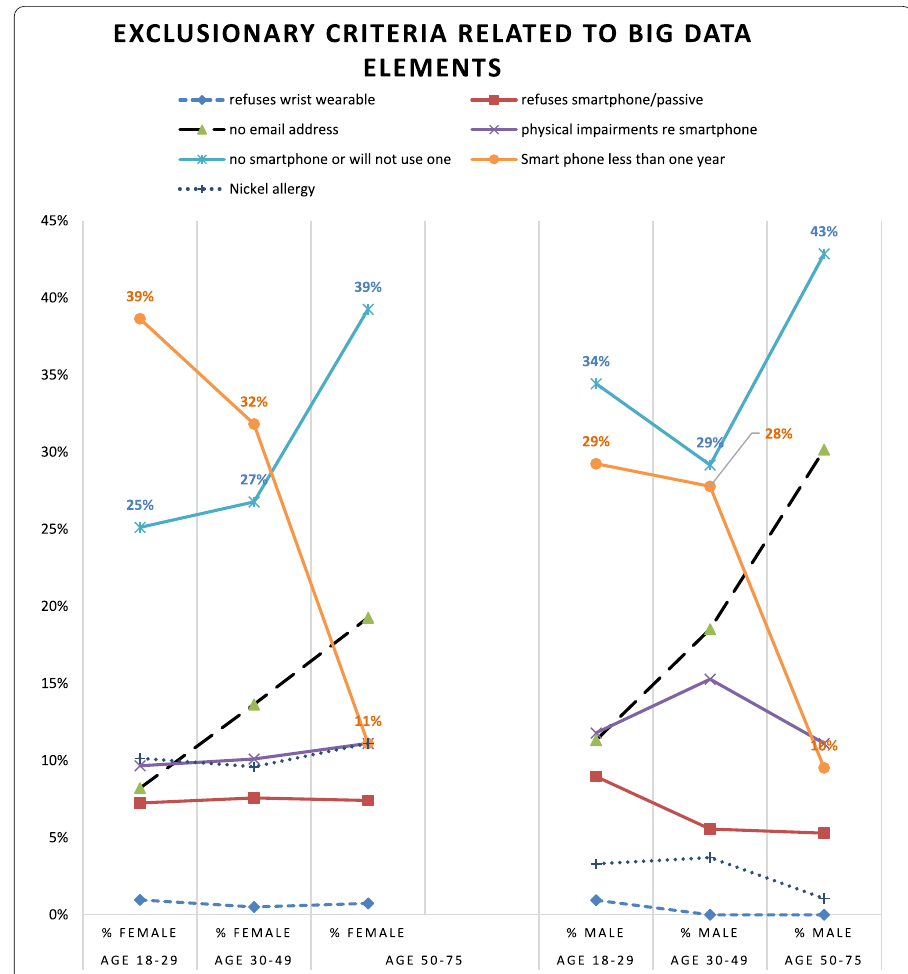
Figure 2 Exclusionary criteria related to big data items. The seven eligibility criteria related to ecological/passive, digital phenotyping, and online neurocognitive assessments are noted. The “ineligibility” denominator consists of n = 1174 participants screened ineligible for one of these seven “big data” exclusion criteria who also provided their